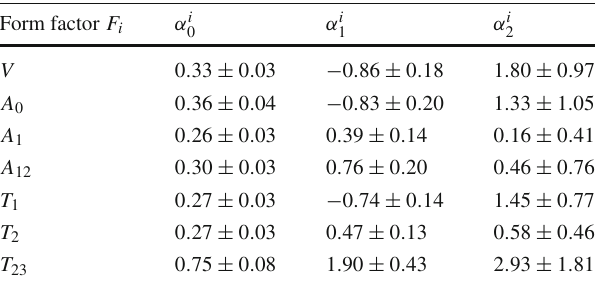
Table 14 Coefficients for the B → ρ form factors [33]